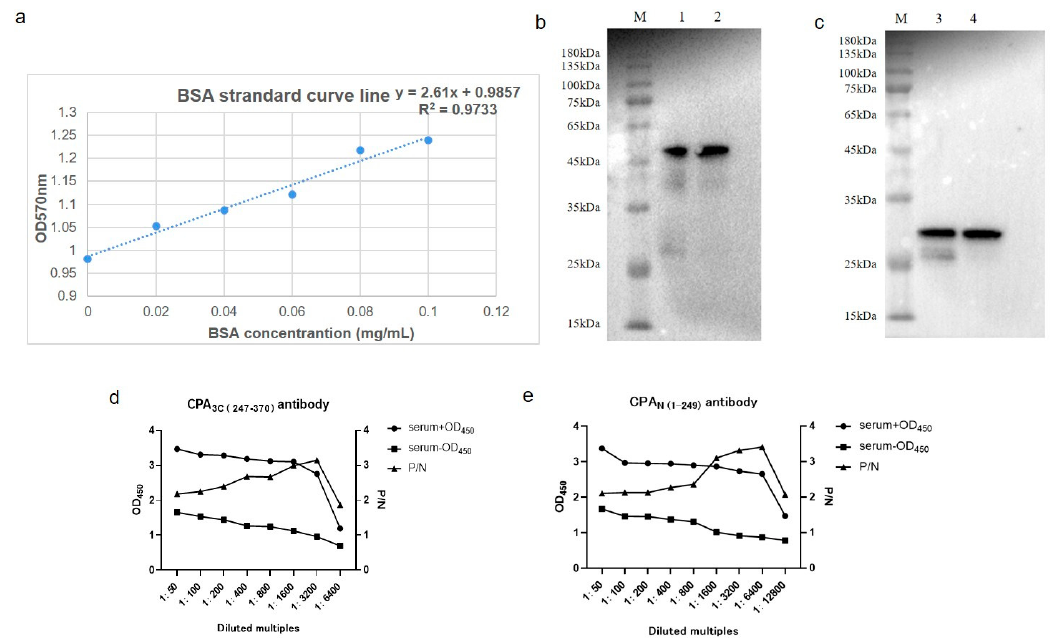
Figure 3. Determination of polyclonal antibody concentration and titer of C. perfringens alpha toxin (CPA C3 and CPA N ). ( a ) Standard curve of antibody concentration measured by Bradford method; ( b , c ) Western-blot results of recombinant proteins CPA C3 and CPA N (M: protein marker (GenStar M221) lane 1–2: CPA C3 recombinant protein, lane 3–4: CPA N recombinant protein). ( d , e ) Indirect